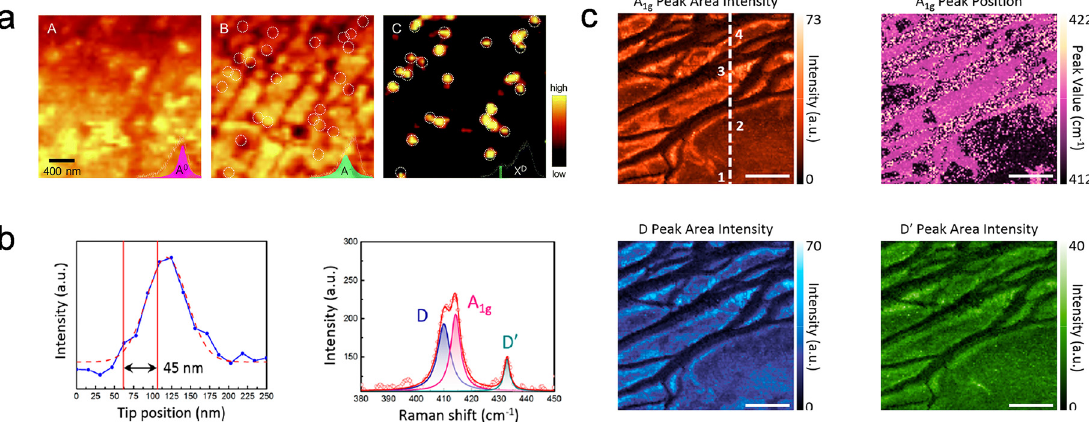
Figure 3: Near-field images of CVD grown 1L-TMDs. (a)Near-fieldPLimagesofexciton,trion,andlocaldefectexcitonof1L-WS 2 ,respectively.Reproducedwithpermissionfromref.[34].Copyright 2017,RoyalSocietyofChemistry.(b)Linepro fi leofTERSintensity(upperpanel)andTERSspectrumof1L-WS 2 (lowerpanel).(c)TERSimagesof A 1g peakarea intensityandpeakposition,respectively(upperpanel)andDpeakandD ′ intensity, respectively(lower panel).Reproducedwith permission from ref. [27]. Copyright 2018, American Chemical